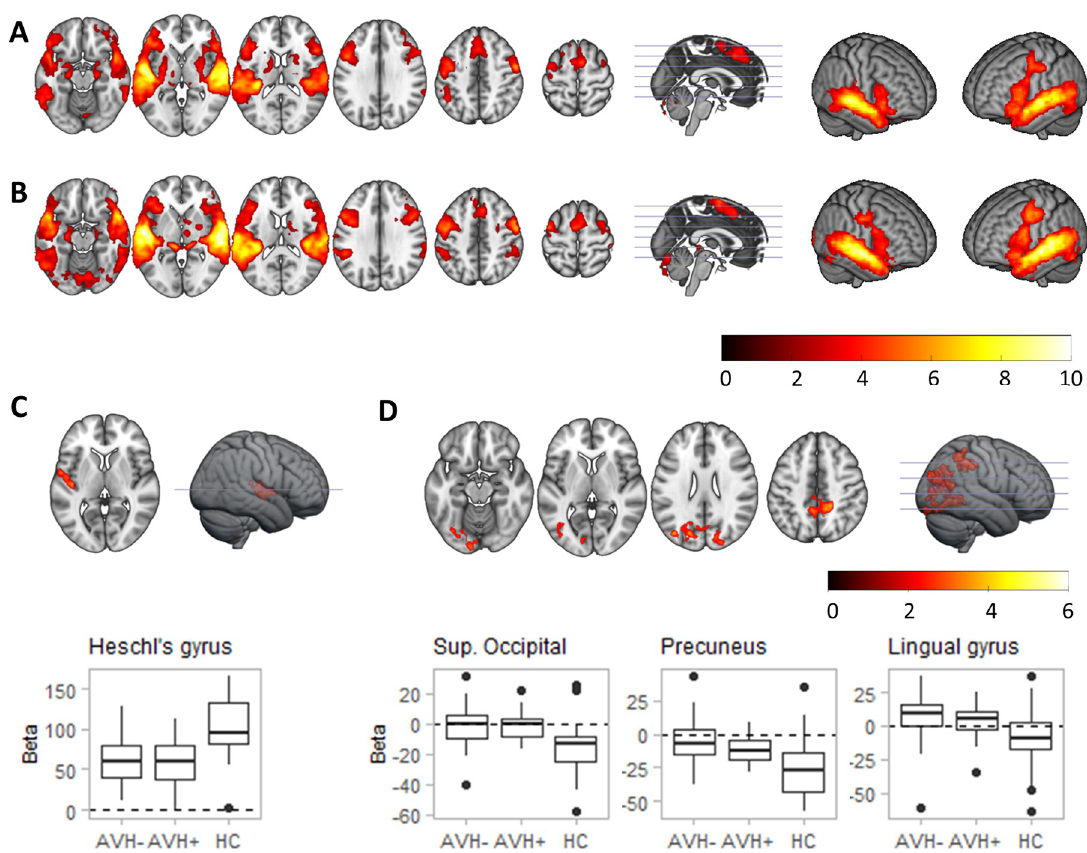
Fig 2. Activation maps for sentences > baseline for healthy controls (A) and patients with schizophrenia (B). (C) and (D) show regions of differences between patients and controls in this contrast, with boxplots depicting parameter estimates (beta values) in each group: (C) shows a region in Heschl’s gyrus hypoactivated in the patients, while regions in (D), corresponding to the superior occipital cortex, the precuneus and the lingual gyrus were hyperactivated in the patients. As shown by the boxplots, this hyperactivation was due to a lack of deactivation in patients. Colour bars depict Z